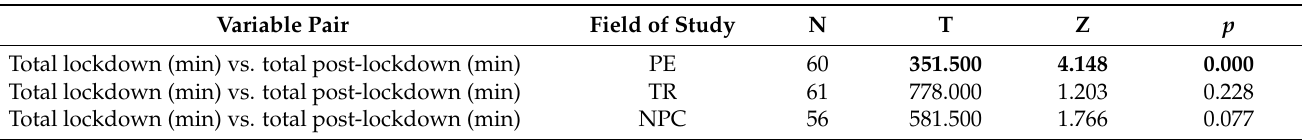
Table 4. Comparison of the physical activity (min) of students in MET in the lockdown and post- lockdown period (Wilcoxon’s signed-rank